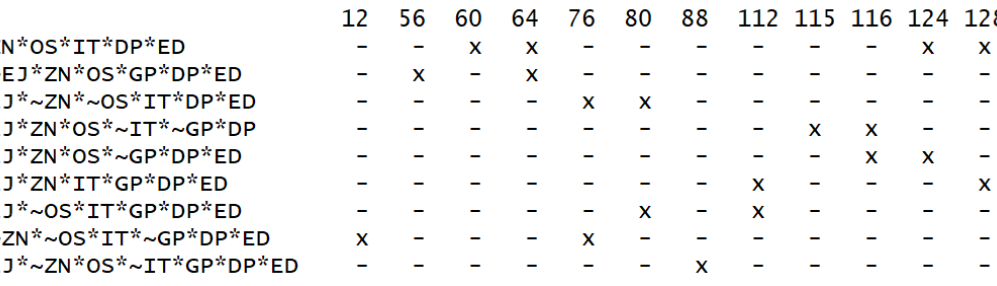
Figure 5. Explanation of the complex (conservative) solution to the research problem.